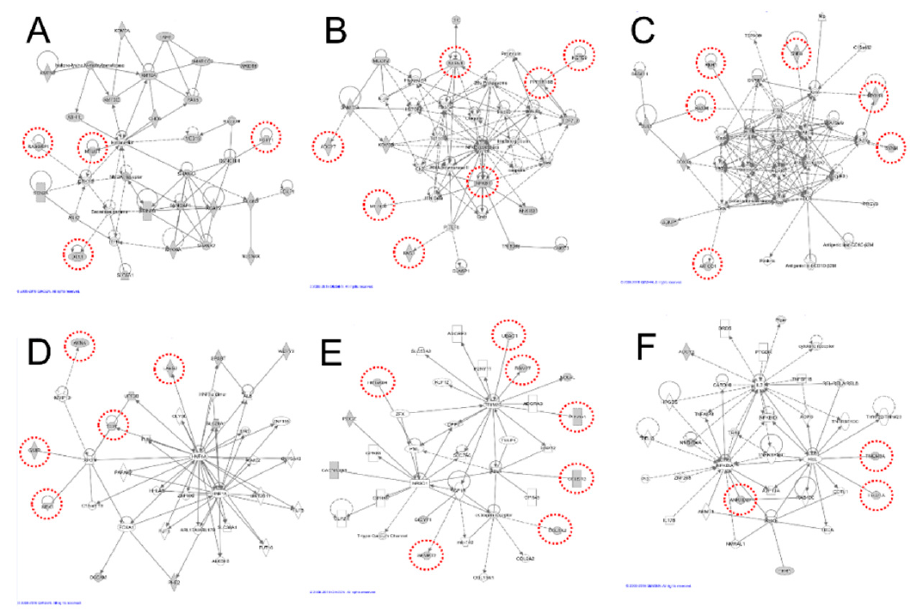
Figure 2. Novel autism spectrum disorder (ASD) risk genes with de novo variants in the gene network. Gene network ( A – F ) ASD risk genes with de novo variants in this study are circled in red and positioned into six gene networks. A: DTX1 , MTUS1 , RASGRP1 , and RUFY1 . B: ADCY7 , ATXN1 , IWS1 , KCTD9 , MT-ND2 , NFKB1 , and PPP1R16B . C: AMIGO1 , HAX1 , MYH14 , RNH1 , SNF8 and SYNM . D: AKNA , GMIP , LARS2 , NEK1 , and TFPT . E: CELSR3 , COL6A2 , HMGXB4 , PIEZO1 , RBM27 , SFMBT2 , and UBAC1 . F: ANKRD27 , TMEM8A , and TTC21A . Table 1. Clinical characteristics of probands.